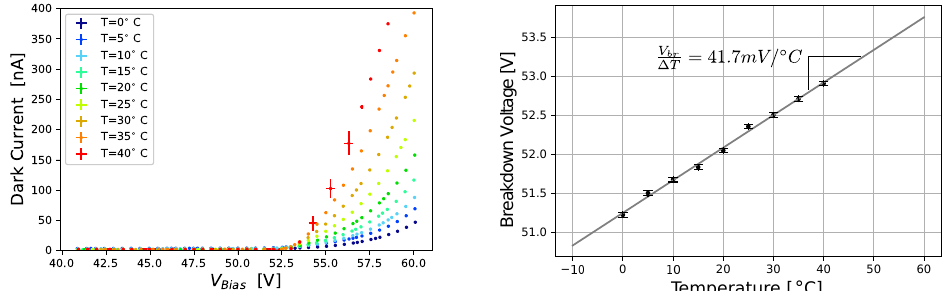
Figure 4. Temperature dependence of the SiPM breakdown voltage. ( Left ): IV curves ranging from 0 ◦ C to 40 ◦ C. ( Right ): Variation of the breakdown voltage V br with